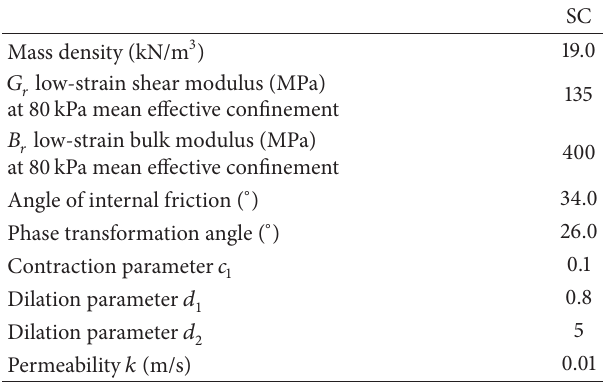
Table 4: Characteristics adopted in the study for SC. Mass density (kN/m 3 ) 19.0